Question: What style of plot is this figure drawn as?
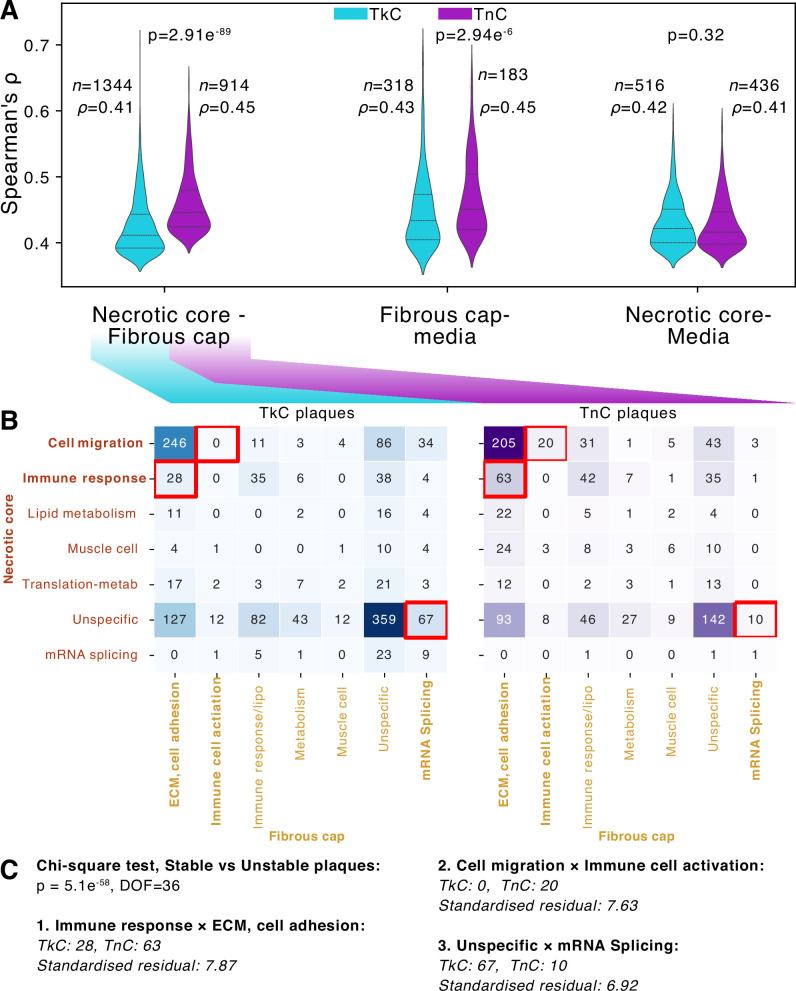
Answer: heatmap